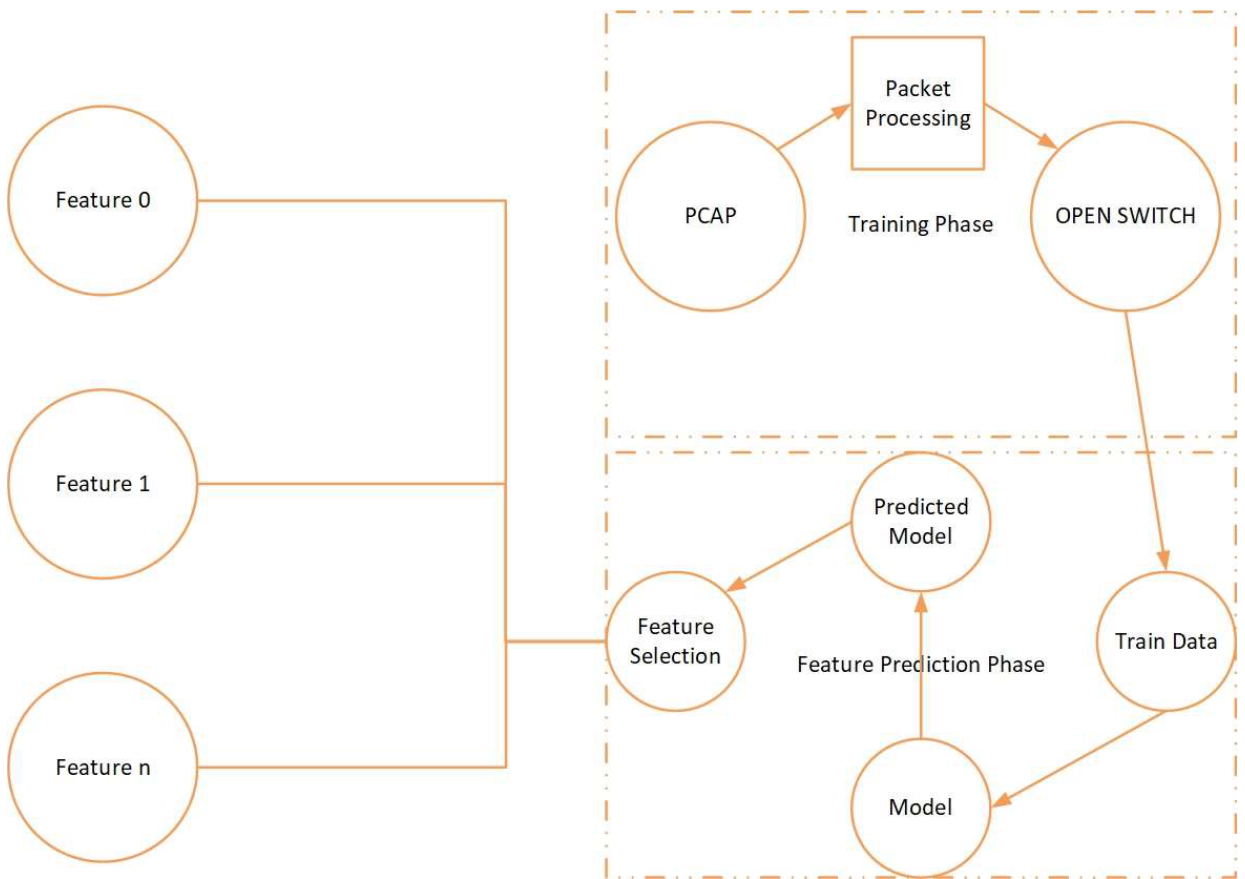
Figure 1. Proposed detection method.